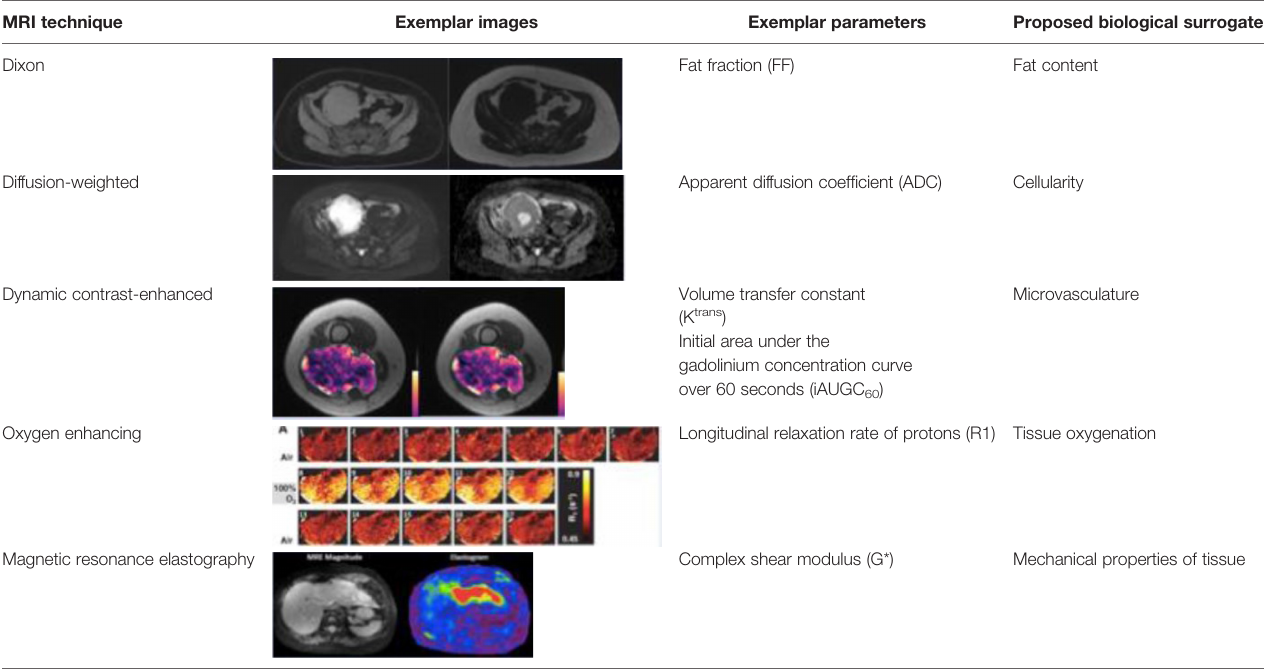
TABLE 1 | Summary of the quantitative imaging techniques described in this paper and that represent potential